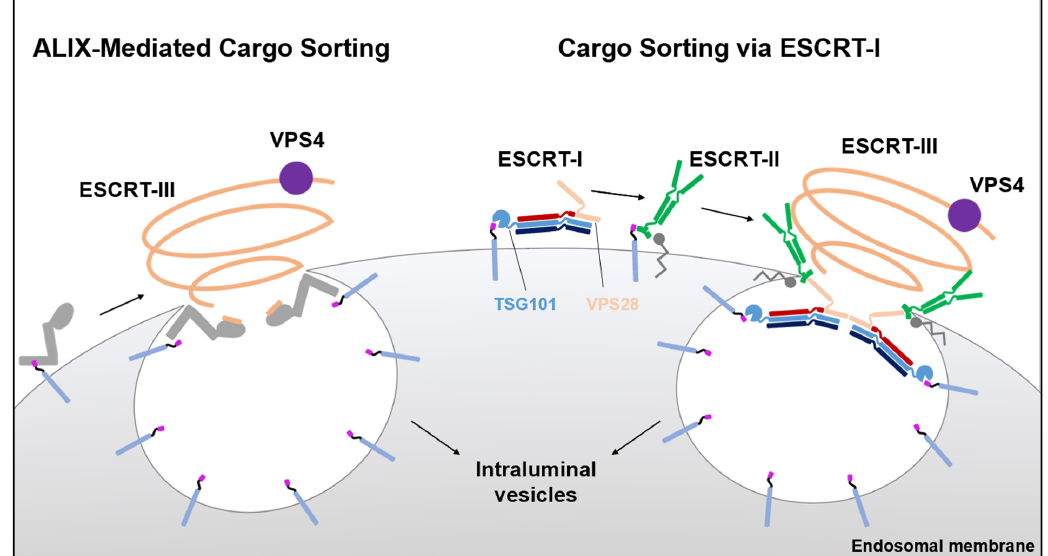
Figure 1. The respective roles of ALIX and ESCRT-I in the sorting of membranous cargo. Upon internalization, ubiquitylated cargo is detected by ALIX ( left ) and ESCRT-I ( right ) for compartmentalization into intraluminal vesicles that are destined for degradation via the late endosome. Both ALIX and ESCRT-I contain ubiquitin binding domains that facilitate this first step. Unlike ESCRT-I, ALIX possesses an ESCRT-III binding domain that allows for the direct recruitment of ESCRT-III and VPS4, the machinery required for sealing of cargo within intraluminal vesicles and abscising these vesicles from the endosomal membrane. In a similar fashion, the ESCRT-I component TSG101 binds ubiquitylated cargo, while the VPS28 component can recruit ESCRT-III through ESCRT-II which also binds ubiquitylated cargo as well as phospho-inositol